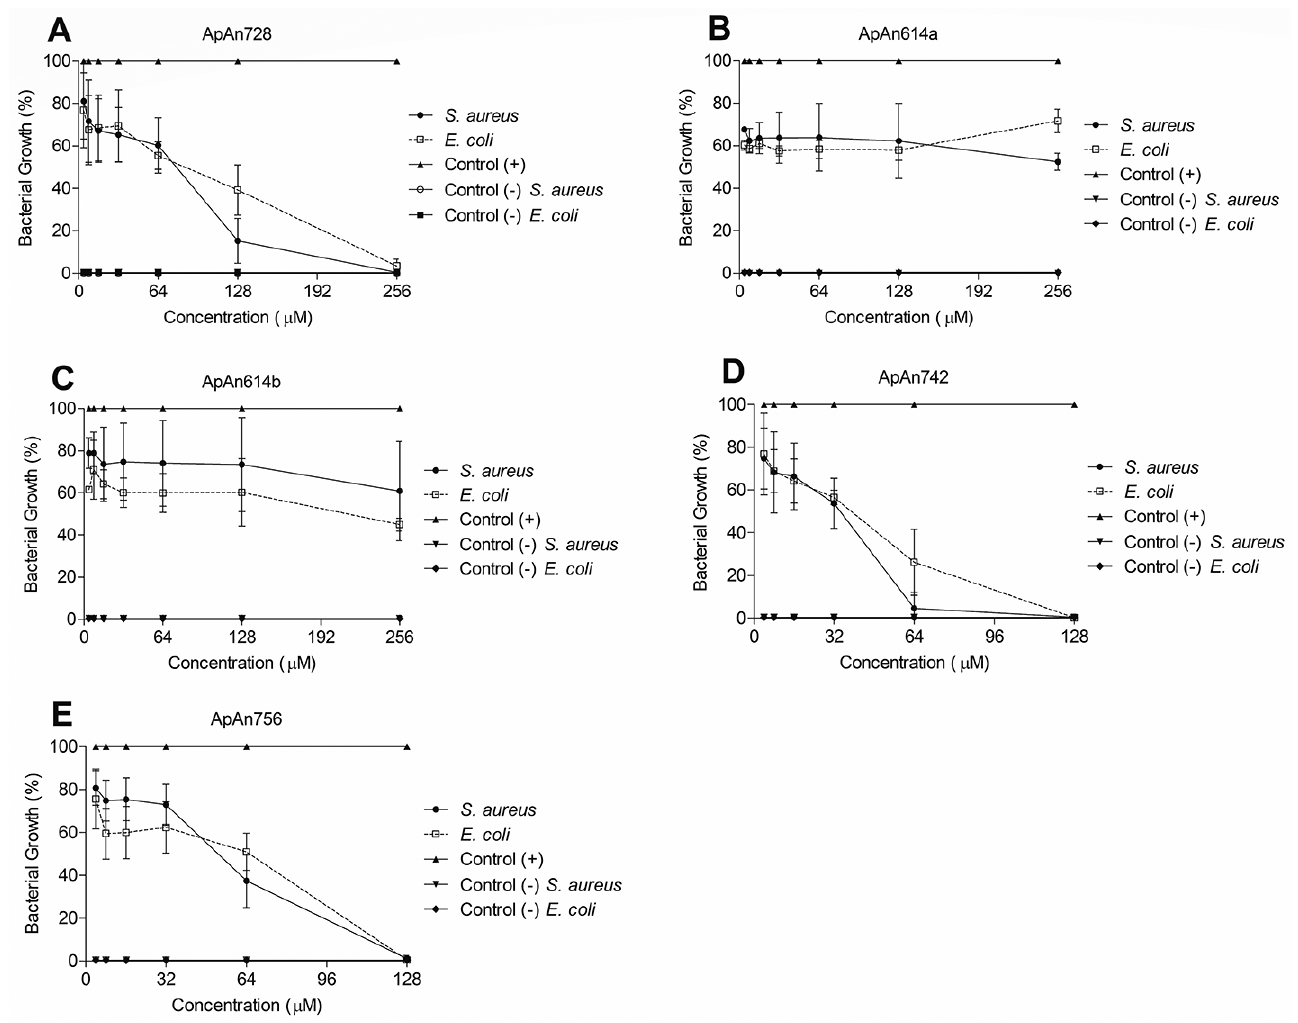
Figure 7. Antimicrobial activity of (A) ApAn728, (B) ApAn614a, (C) ApAn614b, (D) ApAn742 and (E) ApAn756 against Staphylococcus aureus (SA) and Escherichia coli (EC), as a result of the serial dilution from 256 µM to 4 µM or 128 µM to 4 µM concentration, performed to determine the MIC. Data were expressed as mean ±